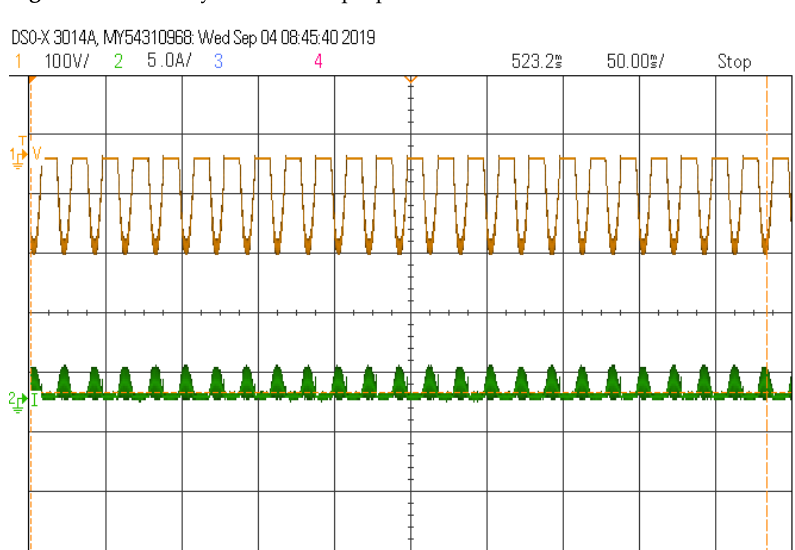
Figure 24. Voltage across and current through the